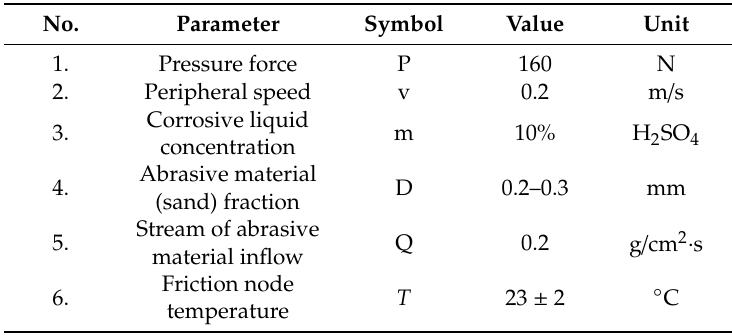
Table 5. Assumed values of input parameters